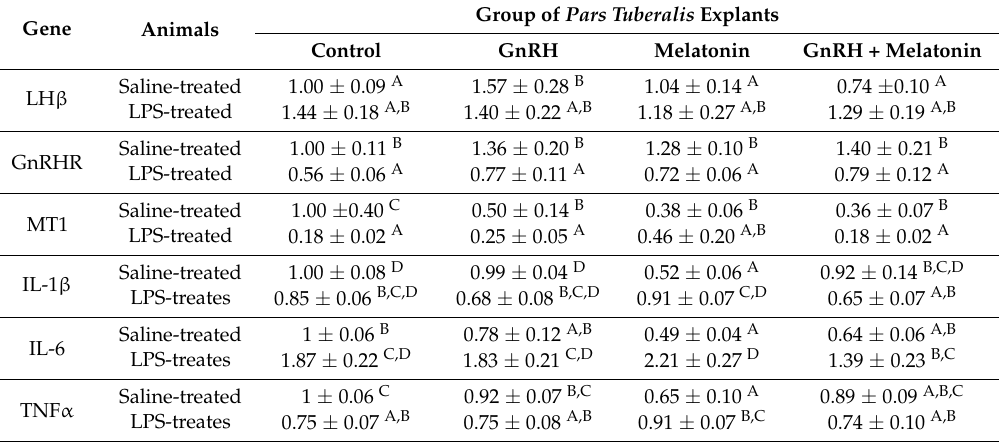
Figure 1. The effects of GnRH (100 pg/mL) and melatonin (10 nmol/mL) on LH release from the Pars Tuberalis explants. All data are presented as the mean ( ± S.E.M.). Different capital letters indicate significant ( p < 0.05) differences according to a repeated-measures two-way analysis of variance (ANOVA, GraphPad Prism, San Diego, CA, USA) followed by a post hoc Sidak’s multiple comparison test. Table 1. The effects of GnRH (100 pg/mL) and melatonin (10 nmol/mL) on the gene expression of LH, GnRHR and MT1 in the Pars Tuberalis explants.